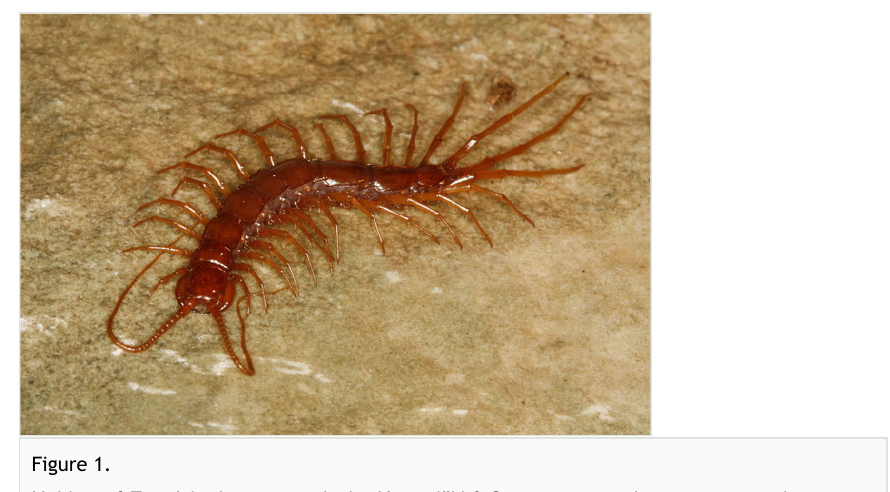
(Fig. 2a); surface smooth, with several minute scattered pits, setae generally absent, except for a few emerging from the marginal ridge (above ocelli) and on the median sulcus. Cephalic median sulcus contributing to biconvex anterior margin, marginal ridge with a median thickening; posterior margin straight or slightly concave; transverse suture situated at about 1/3 of anterior edge; posterior limbs of transverse suture rd